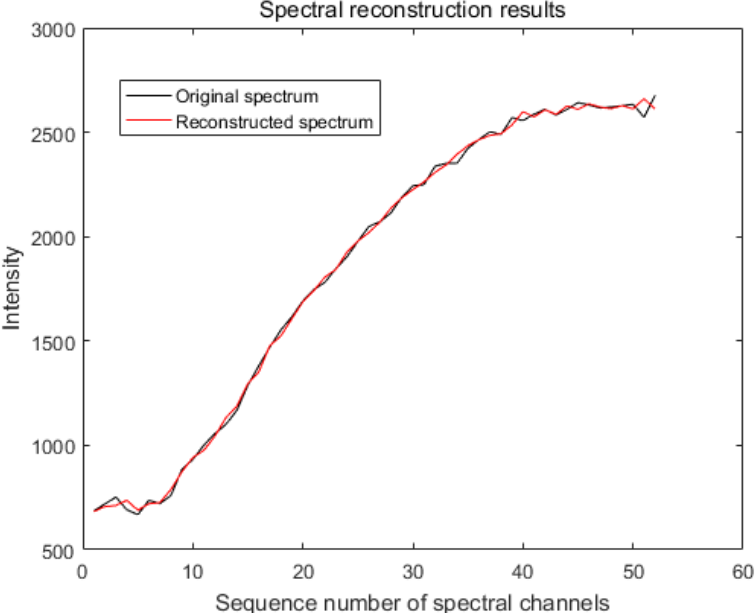
Figure 9. Spectra recovered from 1000 independent experiments using the Monte Carlo method using the GCV-based Tikhonov algorithm vs. the original